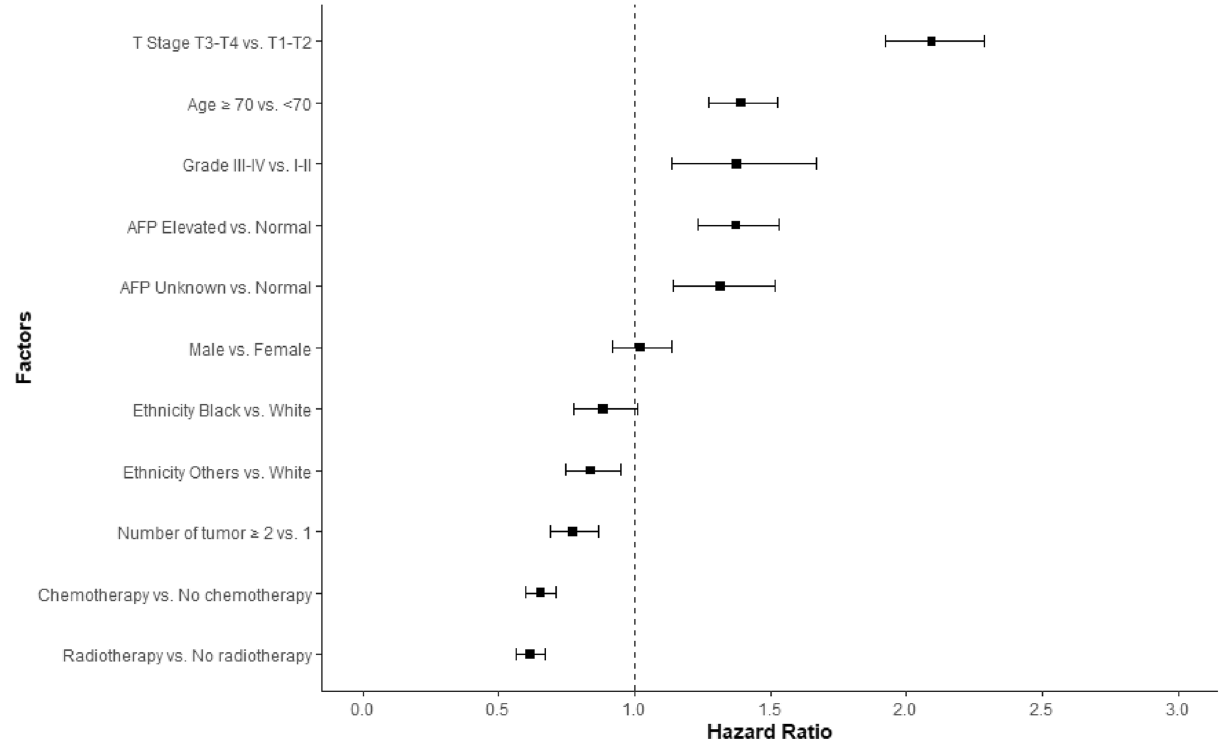
Figure 2. Cox proportional hazard ratios with 95% confidence intervals for data from the SEER database. AFP alpha-fetoprotein.